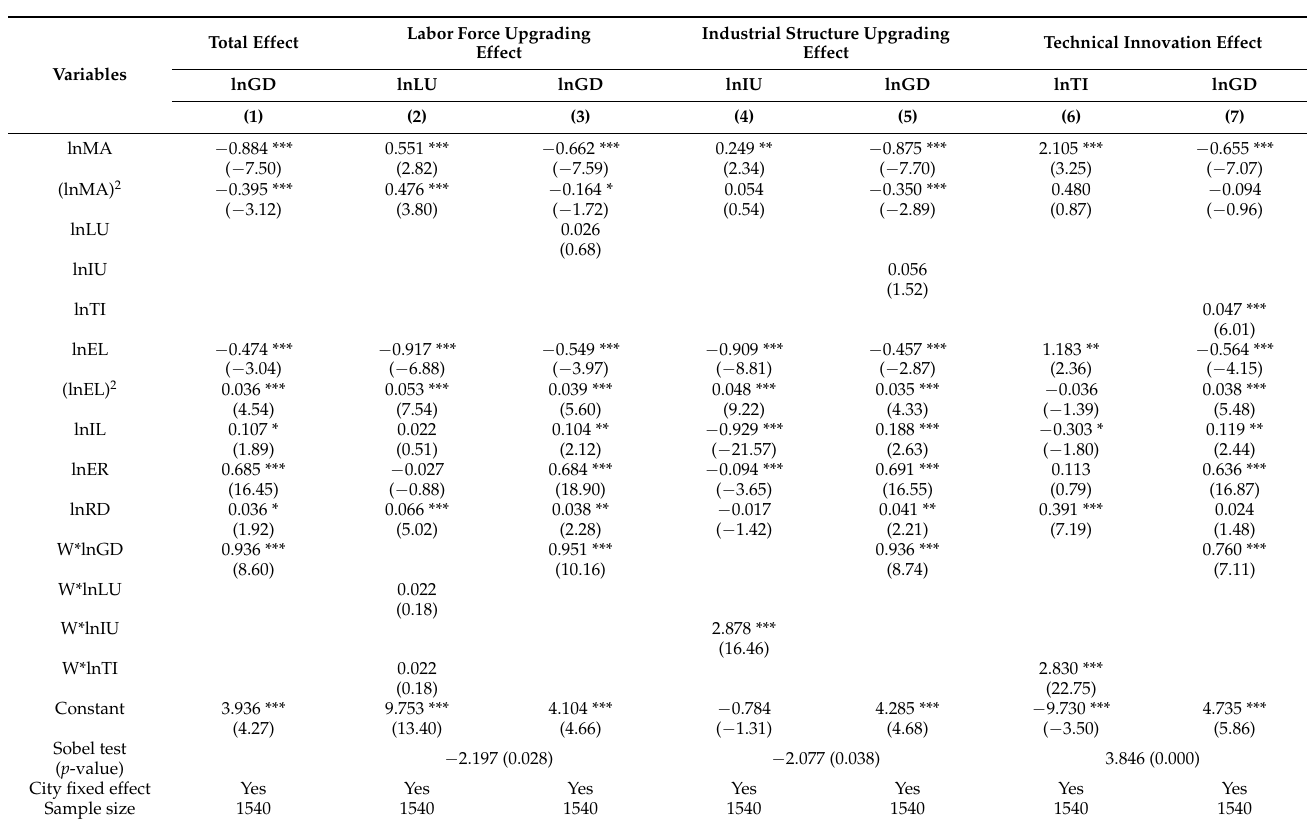
Table 5. Impact path